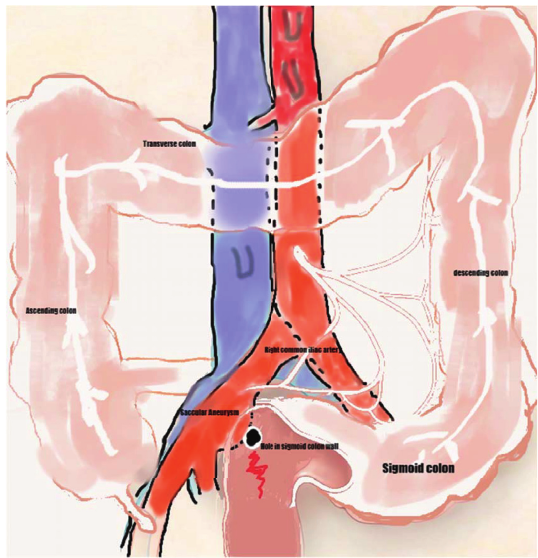
Figure 5: Illustration of the anatomic relations found at operation showing the right common iliac artery aneurysm, sigmoid colon, and the fistula between them.